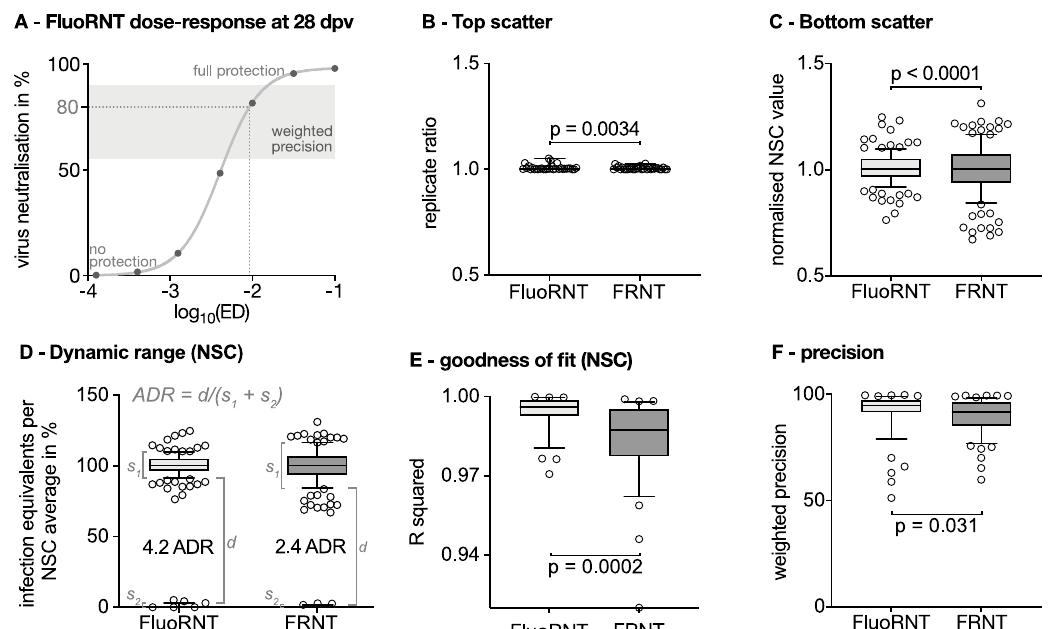
Fig 3. FluoRNT plateau data quality and reliability is superior to that of FRNT. If not described otherwise, all plots are box (25%/75%) and whiskers (10%/90%) plots with data outside the whiskers shown as individual data points. (A) Representative FluoRNT dose-response curve for a patient serum at 28 dpv. The “top” represents values of full protection whereas the “bottom” values of the curve show no protection against YF-17D. The grey area bracketing the ED 80 is used to calculate the weighted precision of technical replicates (see panel F). (B) Scatter of top plateau: Replicates of infectious equivalents (number of foci or percentage of Venus + cells) on 28 dpv at log 10 (ED) = -1 referenced to run-average NSC values, then the greater value is divided by the smaller one (F-test; n = 31). Box and whiskers show minimum and maximum of all data points. (C) Scatter of bottom plateau: infectious equivalents for no-serum controls (NSC) normalised to the run-average NSC (F-test; n = 128;). (D) Assessment of the assay dynamic range (ADR) combining the top and the bottom plateau scatter. Box plot that scatters around 100% displays the bottom scatter as in C (i.e. NSC; n = 128) and box plot that scatters around 0% represents the top plateau scatter as in B brought to the same scale (i.e. replicate ratio of 28 dpv serum at serum dilution log 10 (ED) = -1; n = 31). The dynamic range is calculated as range between the 10 th and 90 th percentile of the upper and lower box (see “d”), respectively and referenced to the distribution widths of both (“s 1 ” and “s 2 ”). The ADR of the FRNT assay is 2.4 while that of FluoRNT is 4.2. All values are referenced to run- average NSC. Panels B-D show technical replicates of study participants of the main cohort. (E) Goodness of fit parameter R 2 for data fit to a 4-parameter sigmoidal dose-response model (n = 32). Median R 2 for FluoRNT is 0.996 and 0.988 for FRNT. Mann Whitney test. (F) Precision of FluoRNT is significantly higher than that of FRNT (58 data points considered for FluoRNT with median of 94.91%, 66 for FRNT with a median of 91.74%). Mann-Whitney test. NSC served as reference for calculation in all